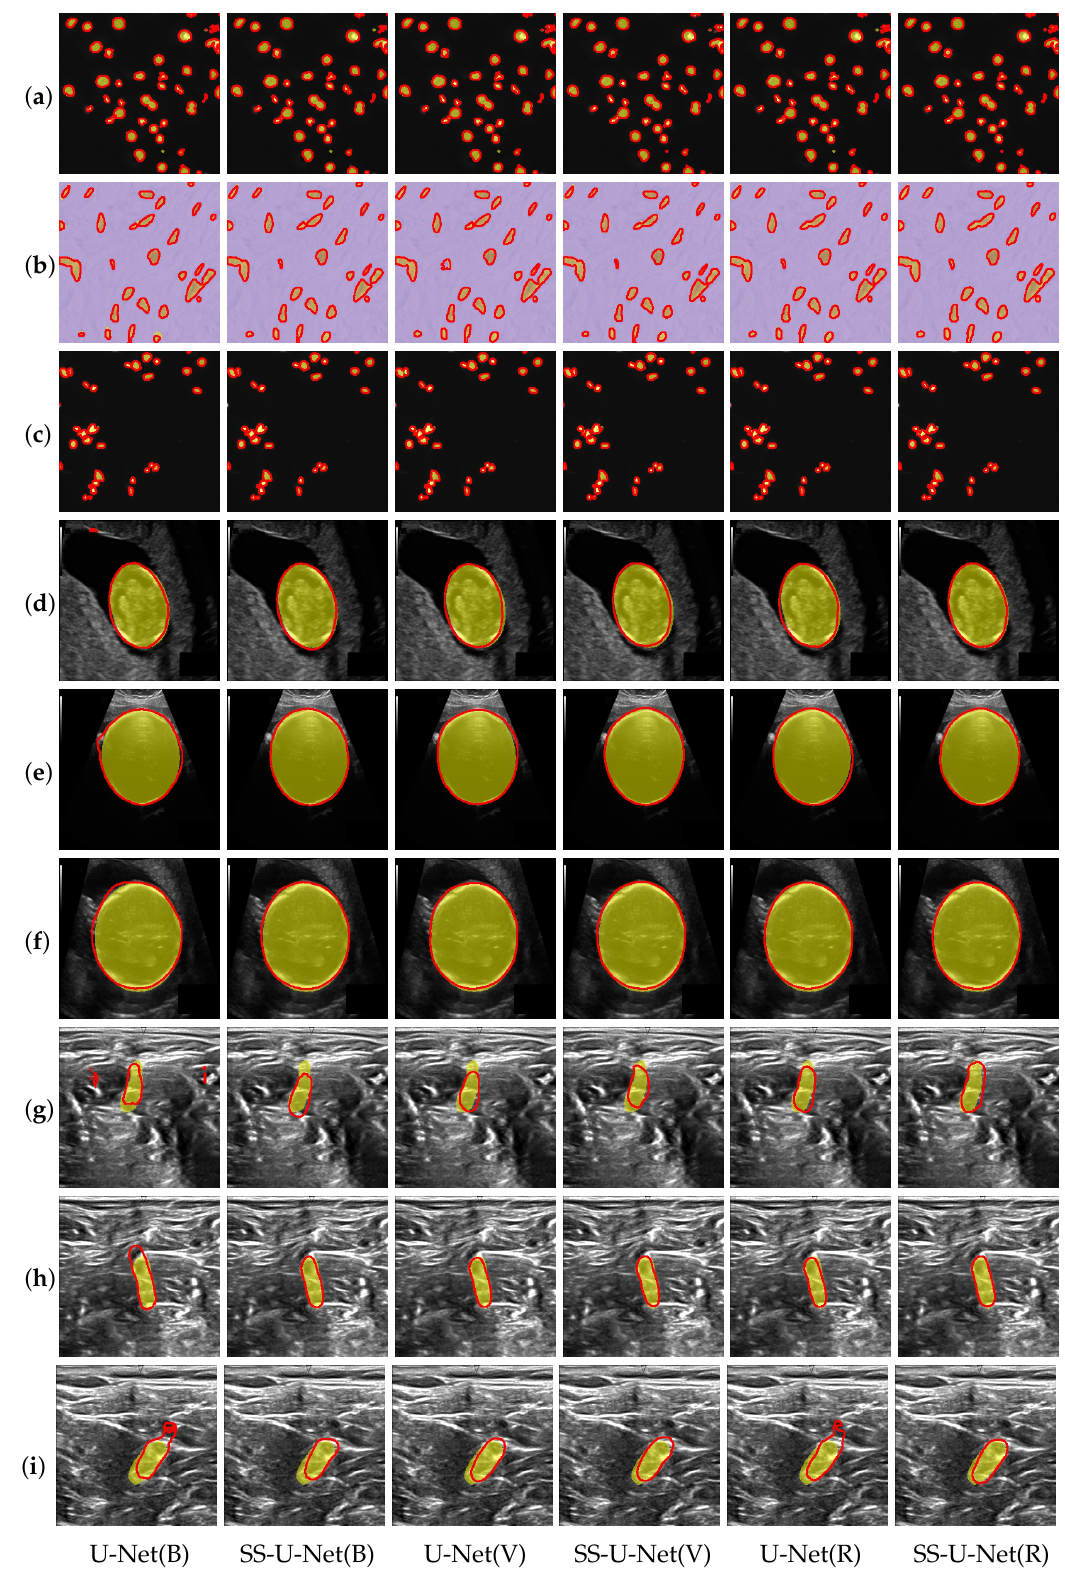
Figure 5. Performance comparison for real medical image segmentation. From top to bottom: each row represents one of the test data sets for three tasks—cell ( a – c ), fetal head ( d – f ), and nerve segmentation ( g – i ), respectively. From left to right: the results are segmented by U-Net(B), SS-U-Net(B), U-Net(V), SS-U-Net(V), U-Net(R), and SS-U-Net(R) approaches,